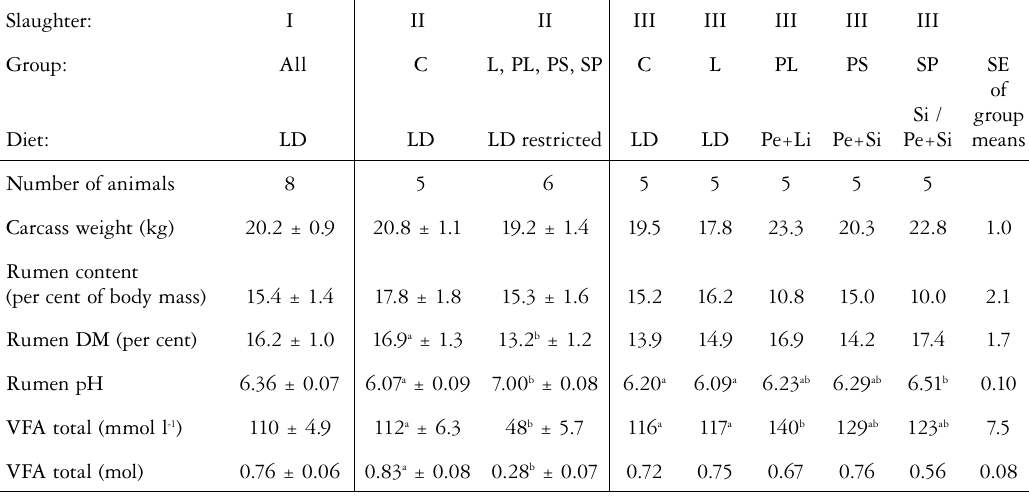
Table 2. Carcass weight, rumen content, rumen dry matter (DM), pH and total volatile fatty acid (VFA) concentration in female reindeer calves fed various diets (Group C, controls, fed a lichen based diet ad libitum , Group L, PL, PS and SP, first fed a restricted amount of the lichen-based diet, half the ad libitum amount, followed by one day without feed and then fed different diets ad libitum ), and slaughtered on three occasions (Slaughter I, at the start of the experiment, Slaughter II after nine days restriction period and Slaughter III, at the end of the experiment) (least square means ± standard errors). Means within row and slaughter occasion with different superscripts are significantly different. Significant changes in controls with time are specified in the text.